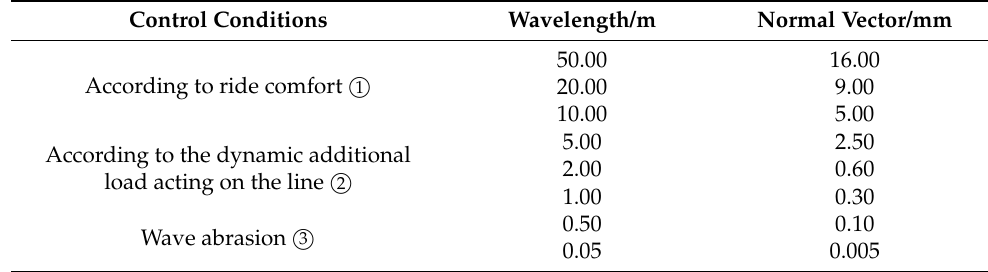
Figure 7. Simulative train load time history curve. The wavelength management values of track geometric irregularity correspond to ① , ② , and ③ in Table 9. Table 9. Track geometry irregularity management value in the UK.